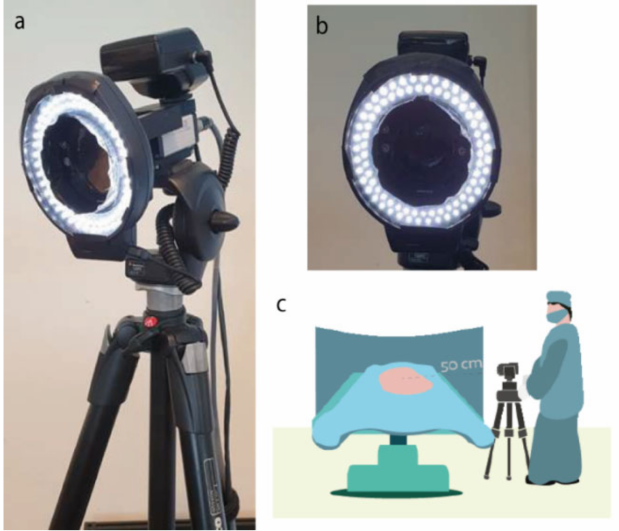
Figure 1. ( a , b ) The iPPG setup consisted of an RGB camera equipped with a Pentax-A 52 mm lens and a LED ring. The entire setup is placed on a tripod which allows the camera to be placed in close proximity to the patient during the surgical procedure. A cross-polarizing filter removes specular reflection and allows diffuse reflection to reach the lens. The camera was connected to a laptop via a Gigabit Ethernet outlet. ( c ) During acquisition, the camera was positioned approximately 50 cm from the target tissue. Camera settings were adjusted